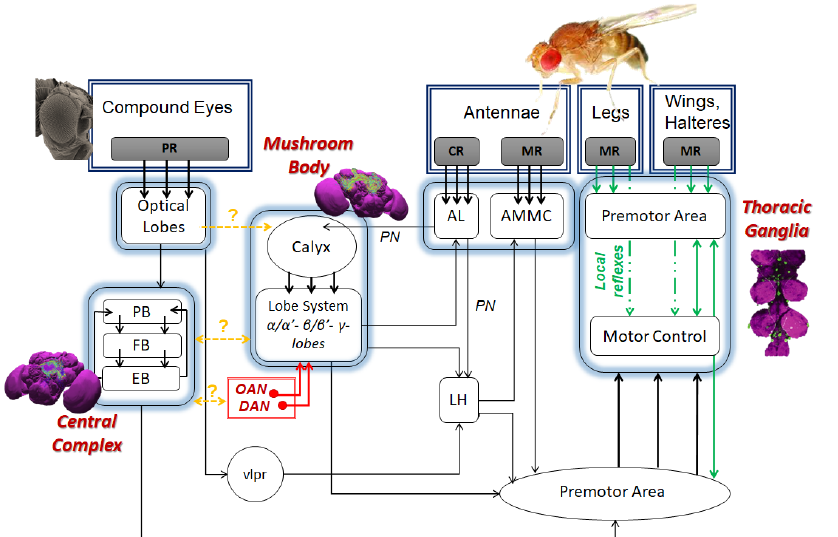
Figure 9. Block-size model of the relevant sensory modalities and neural processing centers in a Drosophila central brain. The insect’s compound eyes photo-receptors (PR) acquire visual stimuli that are initially processed in the optical lobes, and transferred to the CX, and then the neuropile responsible for visual orientation. Chemical-receptors (CR) located in the antennae are responsive to olfactory stimuli whose neural response is transferred through the antennal lobes (AL), and subsequently to the projection neurons (PN), and finally to the MBs. The olfactory and visual inputs are here integrated with the other sensory modalities although their connecting paths are still not evident. The lateral horn (LH) is an inhibitory center that is activated by the PN and the ventrolateral protocerebrum (vlpr) to affect the MBs activity. Dopaminergic (DAN) and octopaminergic neurons (OAN) provide reinforcement learning signals used by learning and memory systems. Tactile stimuli, acquired by the mechanoreceptors (MR) located in the antennae, legs and halters, are locally processed in the antennal mechanosensory and motor center (AMMC) and in the thoracic ganglia for the generation of local reflexes where the CX is also concerned. Table 3. State-of-the-art of the different insect functionalities and behaviors ascribed to the MBs and CX. The subscript associated with each reference indicates the content of the corresponding work: analysis of insect neural circuits and associated behavioral experiments (E), modeling of neural circuits and simulations (S), neural models applied in robotic experiments (R). Insect Brain